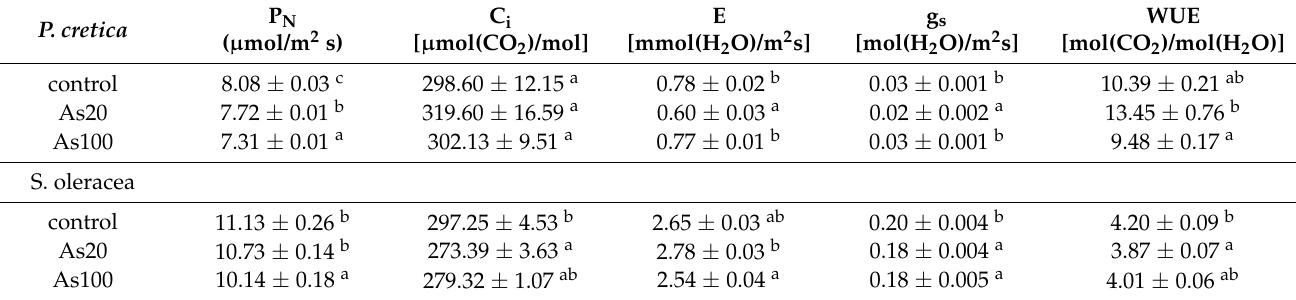
Table 4. Effect of As treatments on leaf gas exchange parameters of Pteris cretica and Spinacia oleracea in a pot experiment. Values represent the mean ± SE of three biological replicates per sample. Data with the same letter are not significantly different. Different letters indicate significant differences ( p ≤ 0.05) among treatments according to the Kruskal-Wallis test.